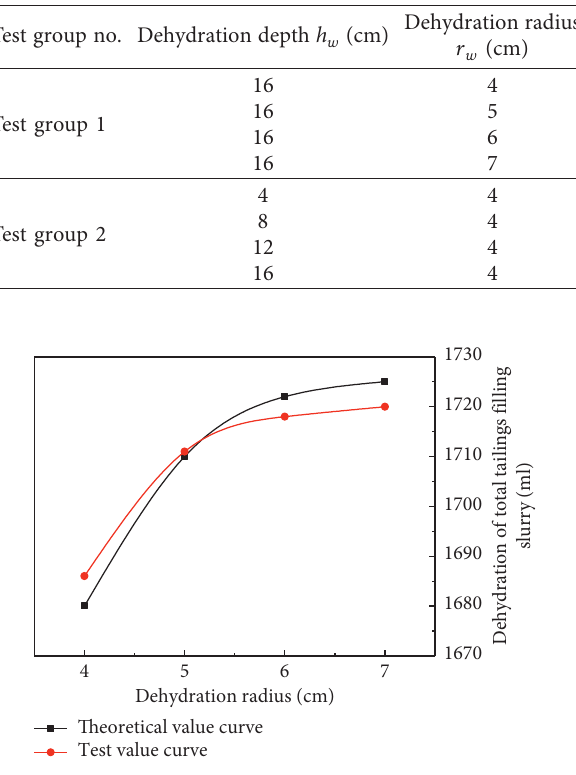
Figure 5: Comparison of the experimental values of the experi- mental group with the theoretical